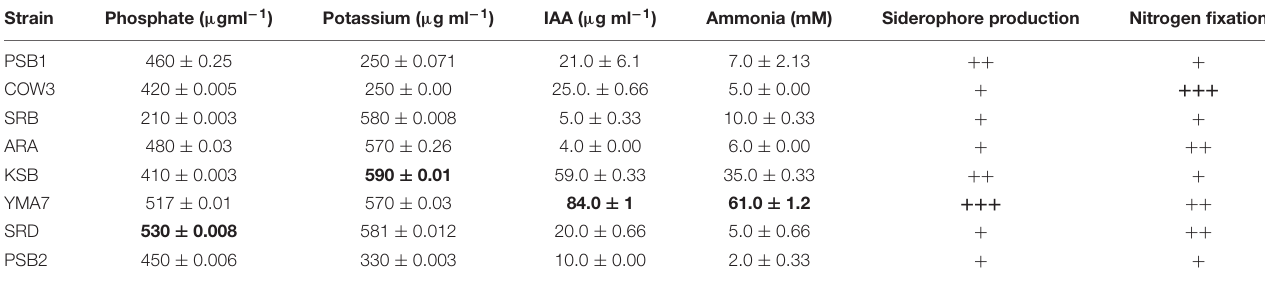
TABLE 2 | PGP traits of isolated bacterial isolates.